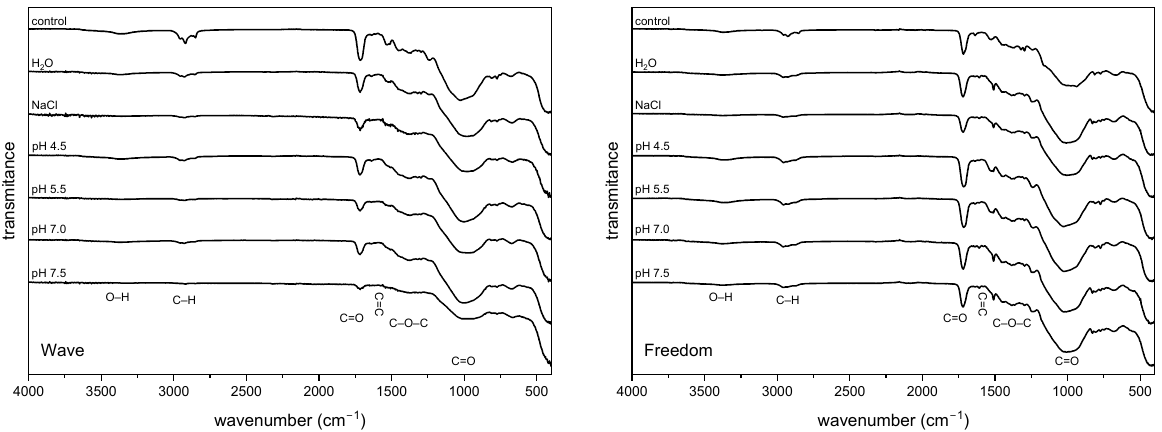
Figure 2. FTIR spectra of Wave ( left ) and Freedom ( right ) materials before and after fluoride release in different media.